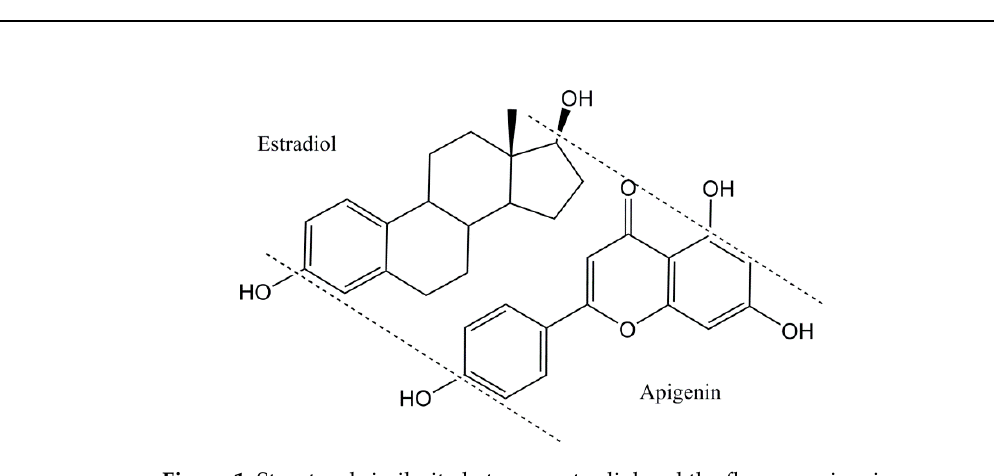
Figure 1 . Structural similarity between estradiol and the flavone